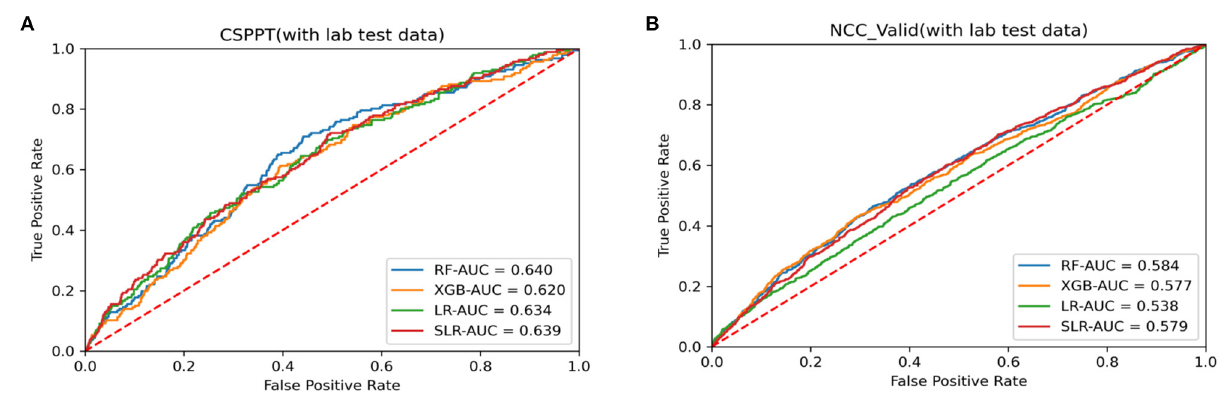
despite showing poor performance in the current